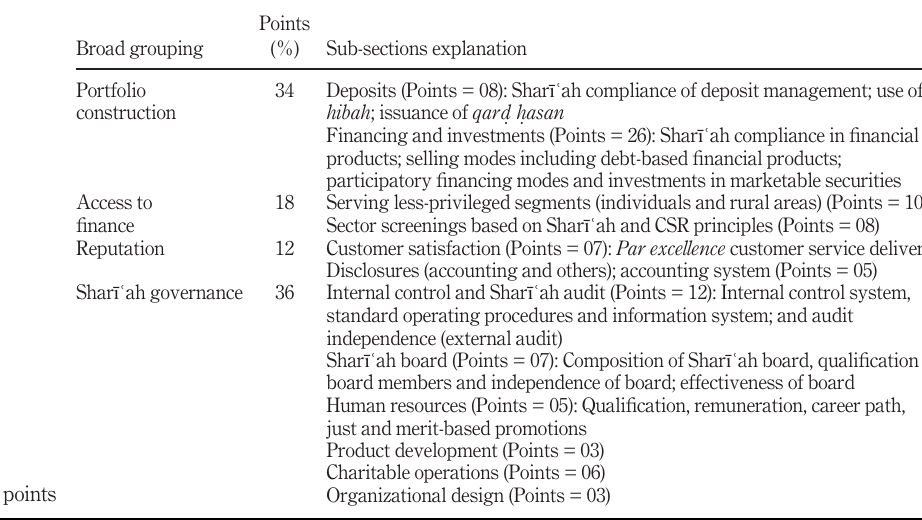
Points (%) Sub-sections explanation